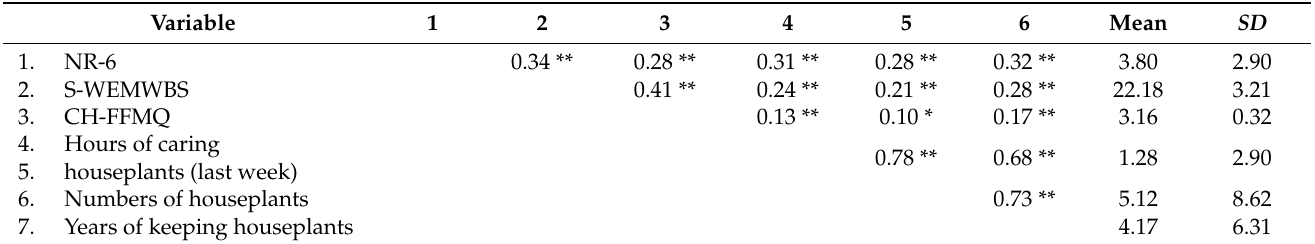
Table 4. Correlations between houseplant behaviour and mindfulness, nature connectedness and